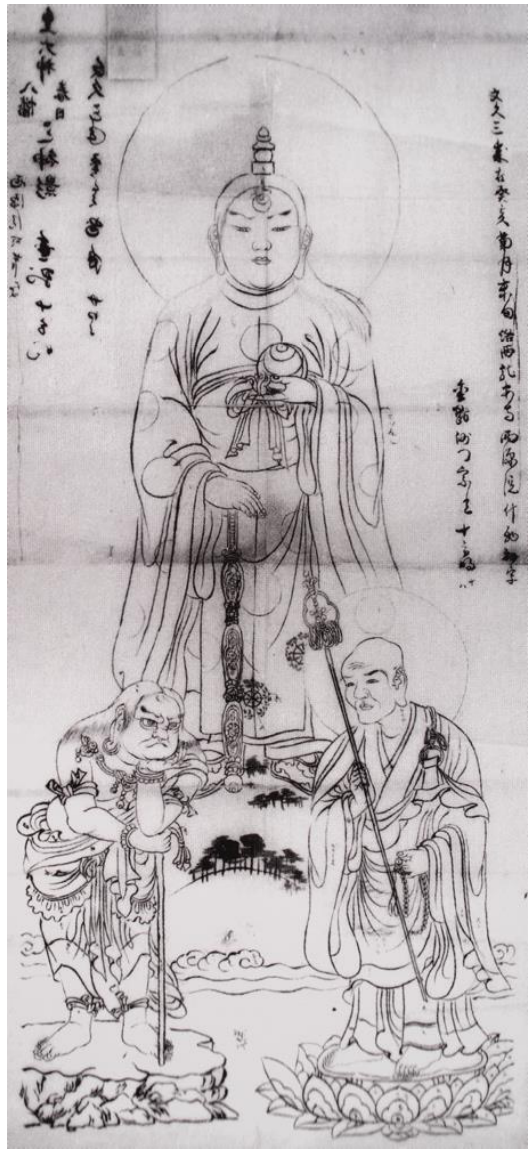
Figure 7. Uh¯o D¯oji (also known as Sanja Gongen ; Manifestations of the Three Shrines), Edo period, sheet, ink on paper. University Art Museum, Kyoto City University of Arts. Reproduced with permission from Faure (2016). Copyright 2016 University of Hawai‘i Press. While the majority of pilgrimage mandalas depict the sun and moon, only the Kong¯osh¯oji Ise Pilgrimage Mandala includes this third iconographical component, which refers to Kong¯osh¯oji’s origins in Kok¯uz¯o and the Morning Star Meditation—Kok¯uz¯o is identified with Venus (My¯oj¯o), and both deities are at the center of the ritual. 29 The symbolic form ( sammaya ) of Kok¯uz¯o, moreover, is the wish-granting jewel. During the Morning Star Meditation the practitioner forms and recites only the wish-granting jewel mudra and mantra (Teeuwen and Rambelli 2003, p. 132). 30 We may therefore think of Kok¯uz¯o, Venus (My¯oj¯o), and the wish-granting jewel as being equivalent and interchangeable in medieval esoteric thought and iconography (Dolce and Matsumoto 2010, p. 179). Amaterasu came to be incorporated into this Buddhist system and by the fourteenth century was commonly equated with the wish-granting jewel (Figure 9).